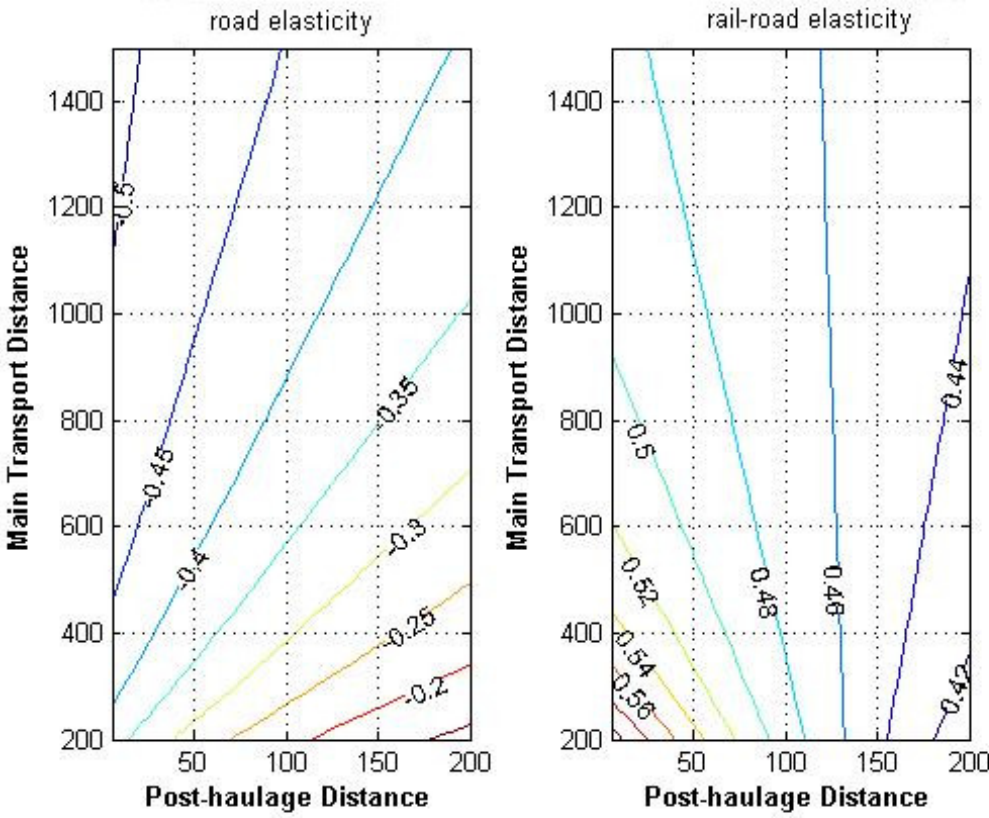
Figure 4. Elasticity isograms when road costs are reduced by